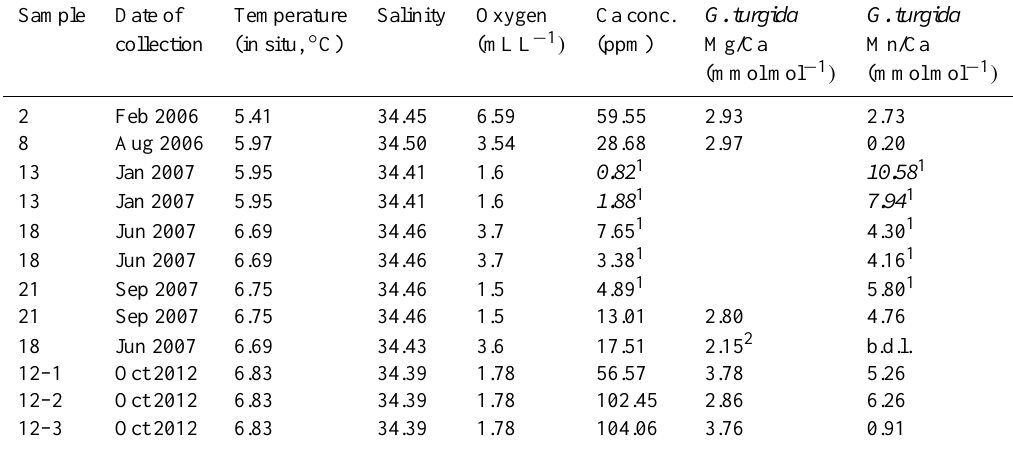
Table 2b. Water mass characteristics during sample collection in the Gullmar Fjord and Mg/Ca and Mn/Ca for G. turgida .